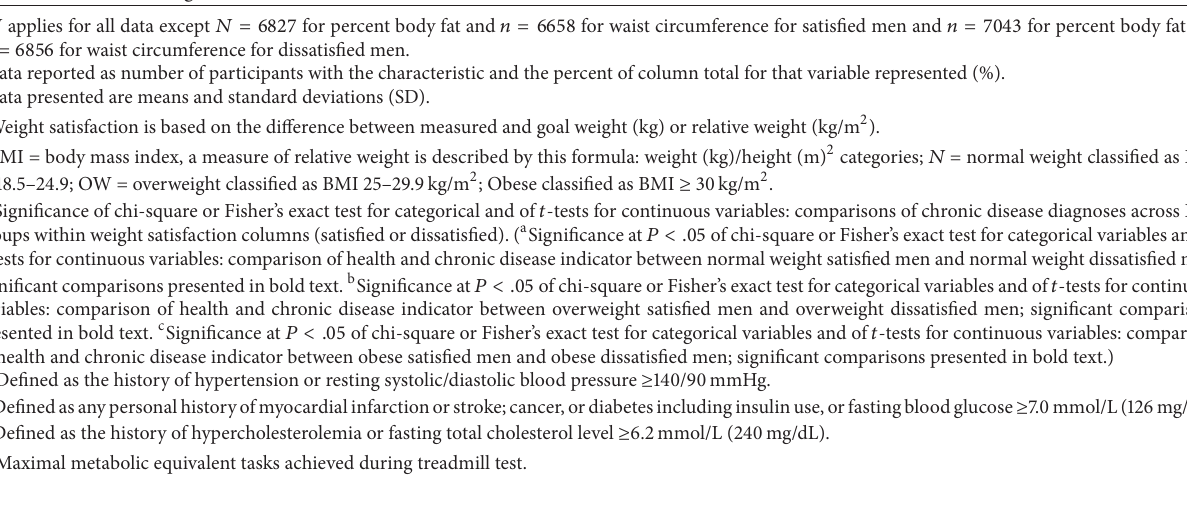
Satisfied (𝑛 = 7121) § Dissatisfied ( 𝑛 = 7287 ) Normal Normal Overweight Obese Overweight 𝑃 ⨀ Weight ¶ Weight ( 𝑛 = 2493 ) ( 𝑛 = 45 ) ( 𝑛 = 4516 ( 𝑛 = 4583 ) ( 𝑛 = 499 )